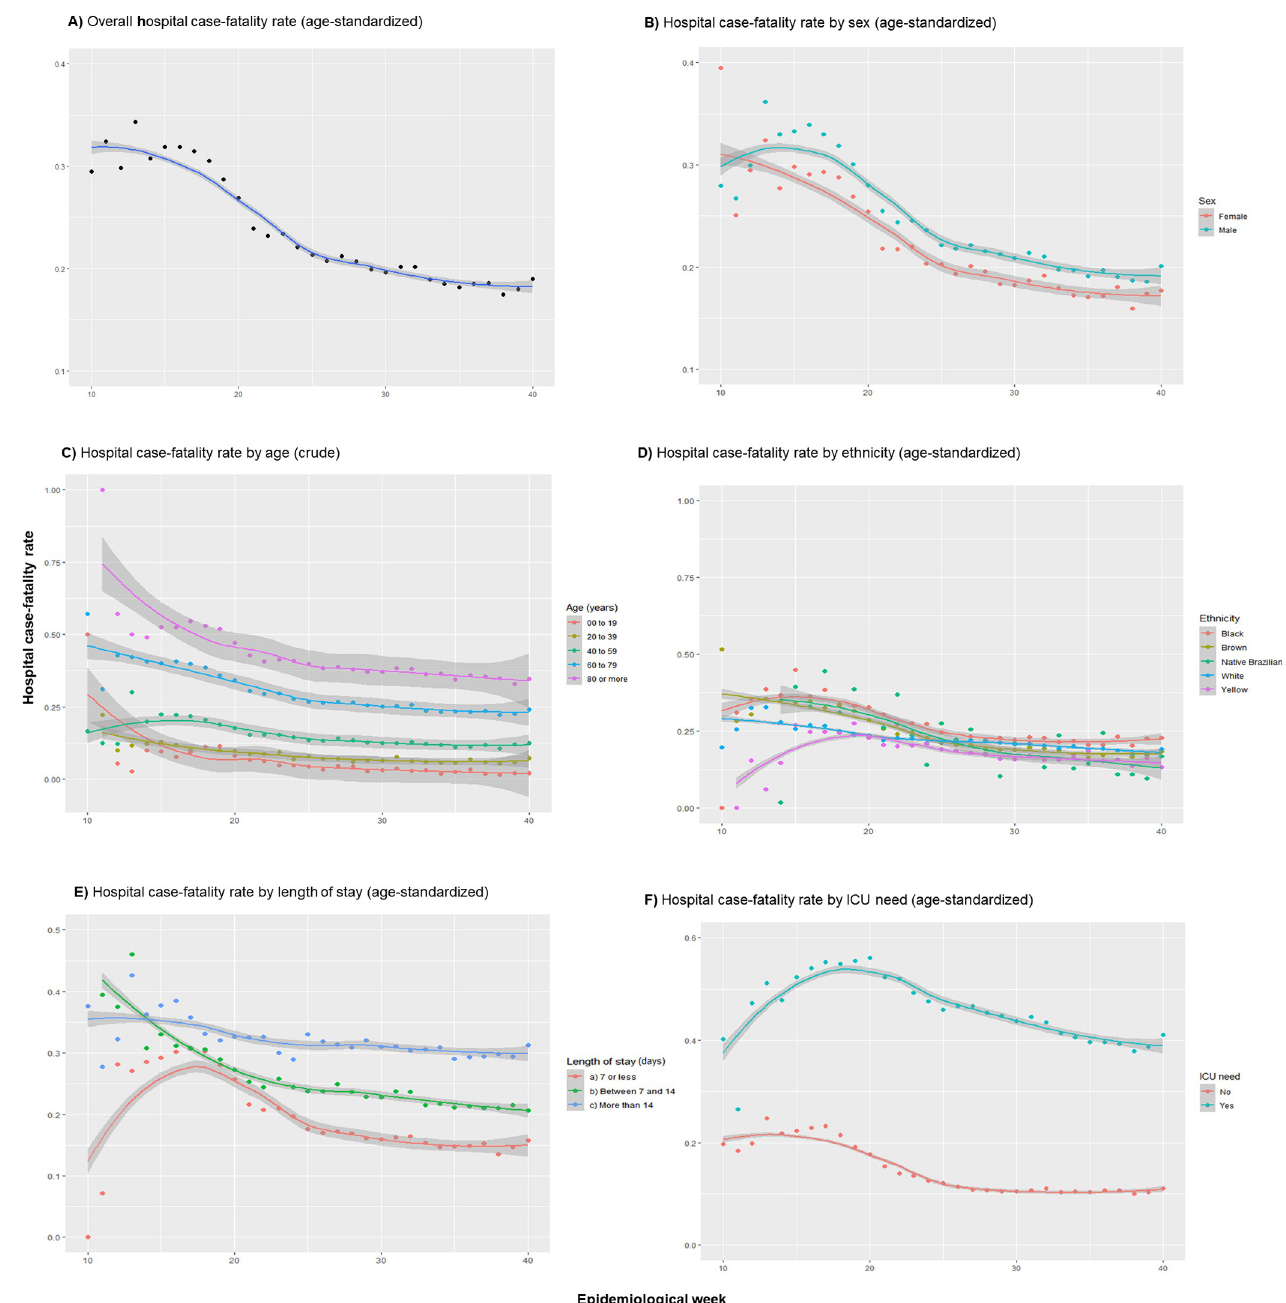
Fig 3. Timeline of 398,063 COVID-19-related hospital case-fatality rates of all admissions stratified by sex, age, comorbidities, ethnicity, length of stay and ICU need during epidemiological weeks 10 to 40, Brazil, 2020.